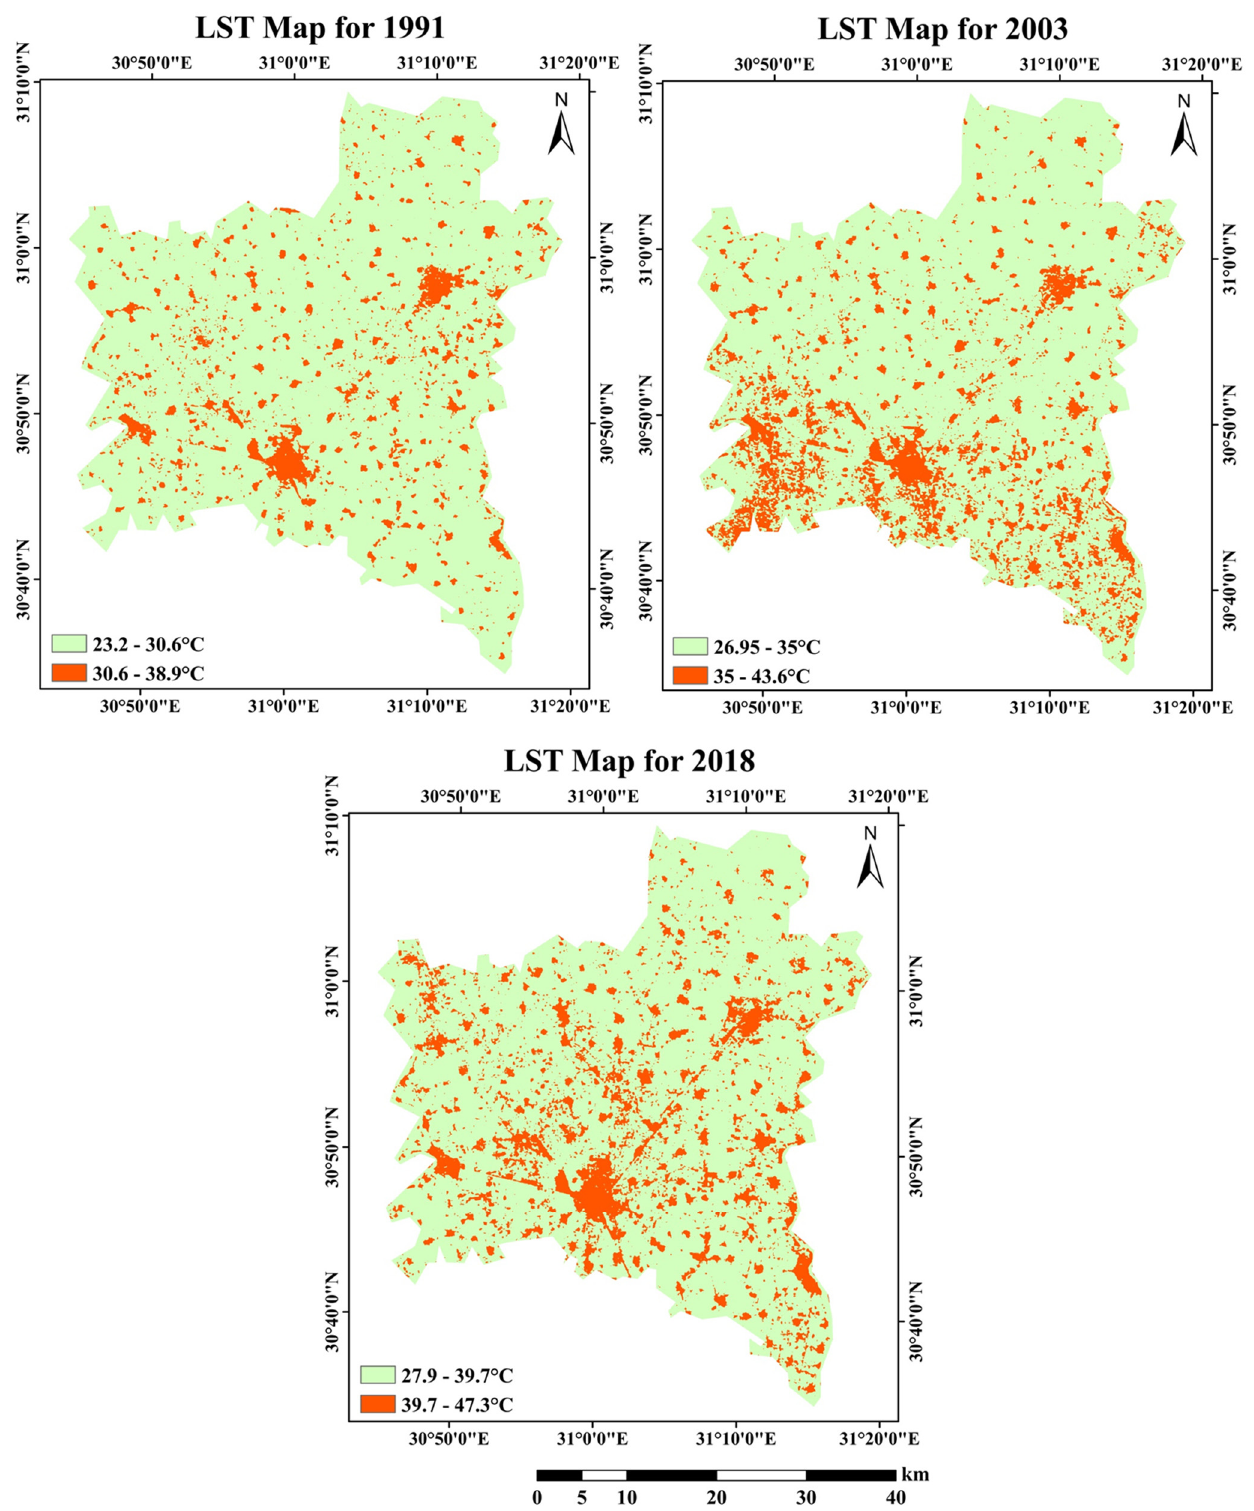
Figure 7. Spatial distribution of daytime land surface temperature (LST) over the study area during the study period in June 1991, 2003, and 2018, all at around 8:00 am.